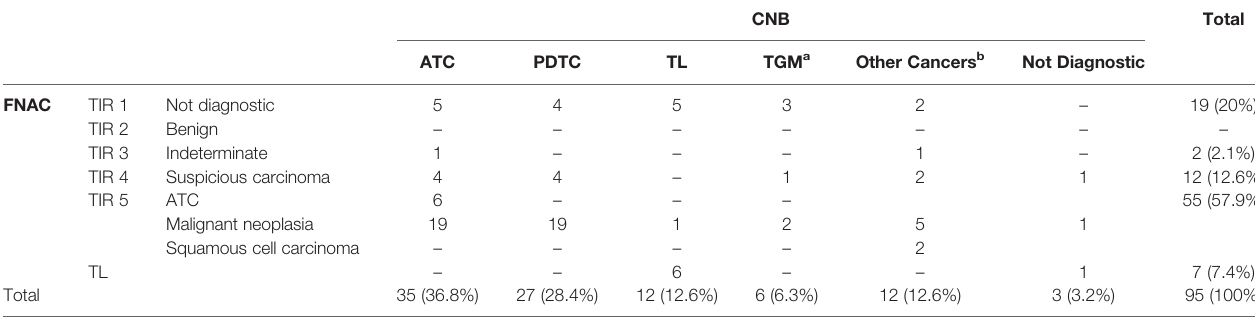
TABLE 4 | Comparison of the results of FNAC and CNB in rapidly growing thyroid masses ( n = 95).